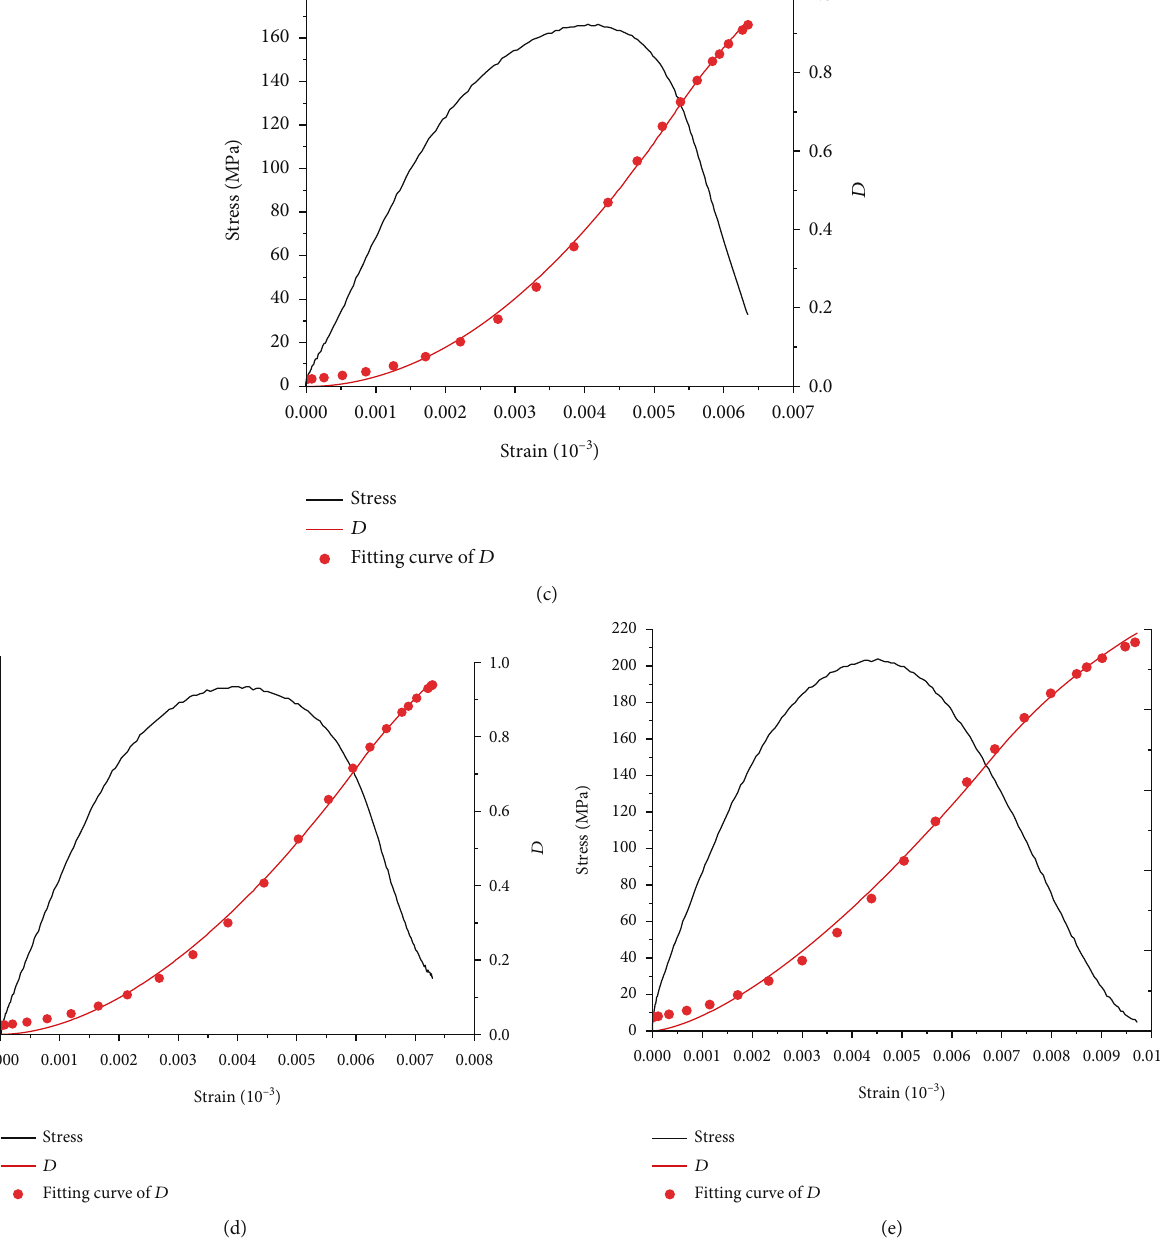
Figure 10: Stress-strain curves and D -strain curves: (a) 34.72s -1 , (b) 45.22 s -1 , (c) 50.34s -1 , (d) 59.97s -1 , (e) 67.32 s -1 Table 2: Fitting equations of samples under di ff erent strain rates.